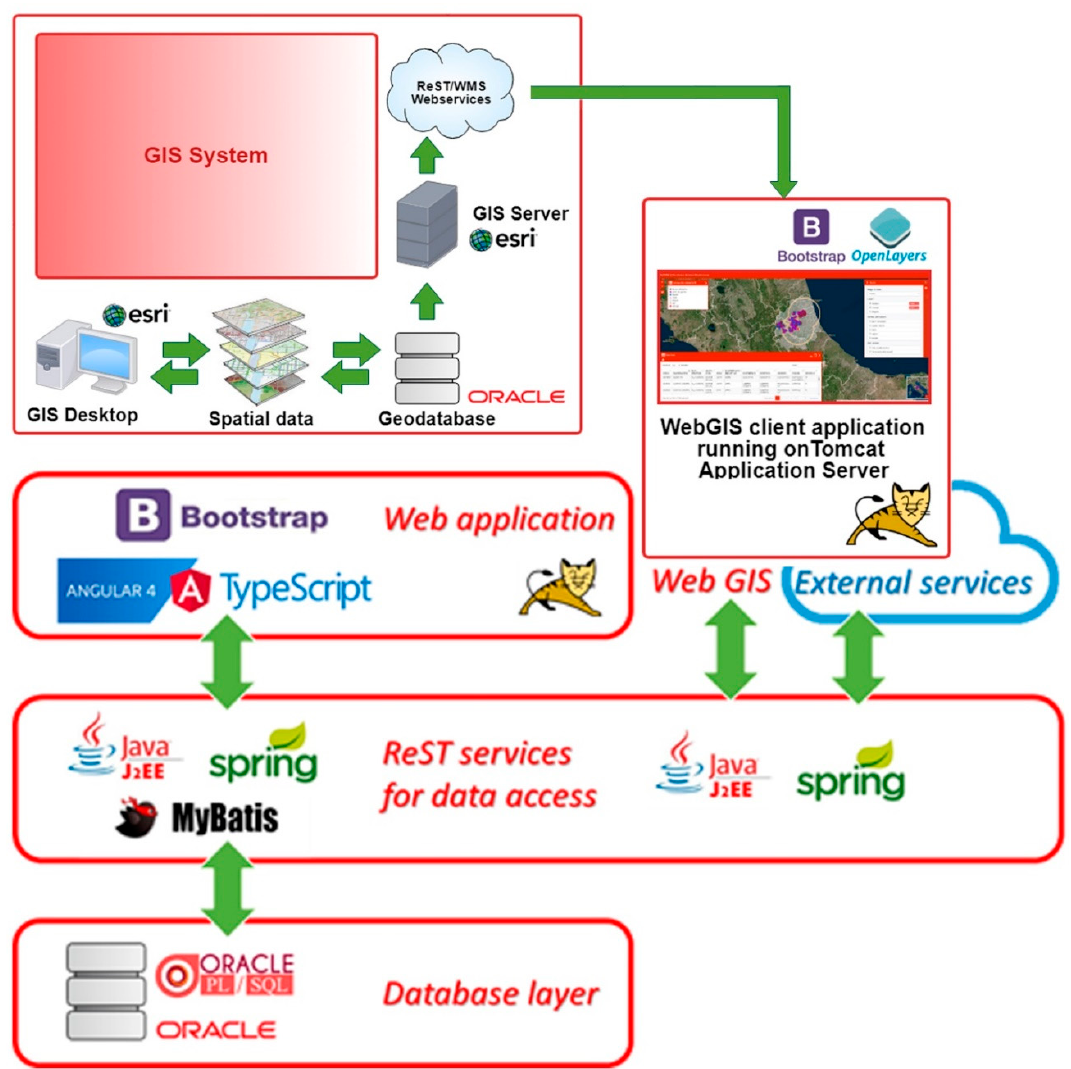
Figure 1. SIVENE architecture.